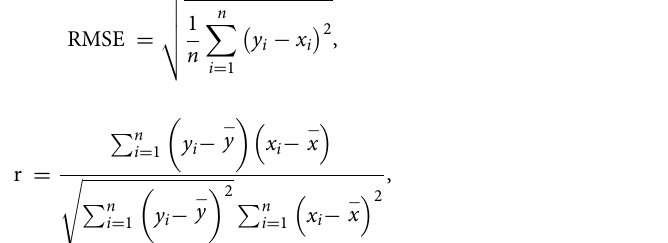
Fig. 2. And the details on the process of the optimization are presented next. In regression analysis, mean square error ( MSE ), root mean squared error ( RMSE ), mean absolute error ( MAE ) and the correlation coefficient r , which are the most commonly used evaluation indicators. The r value is an indicator of the degree of correlation between variables. A positive r value means that the dependent variable increases with the independent variable, and the fitted straight line rises from left to right. The MAE is used to measure the average absolute error between the prediction value and the real value on the experimental data set,